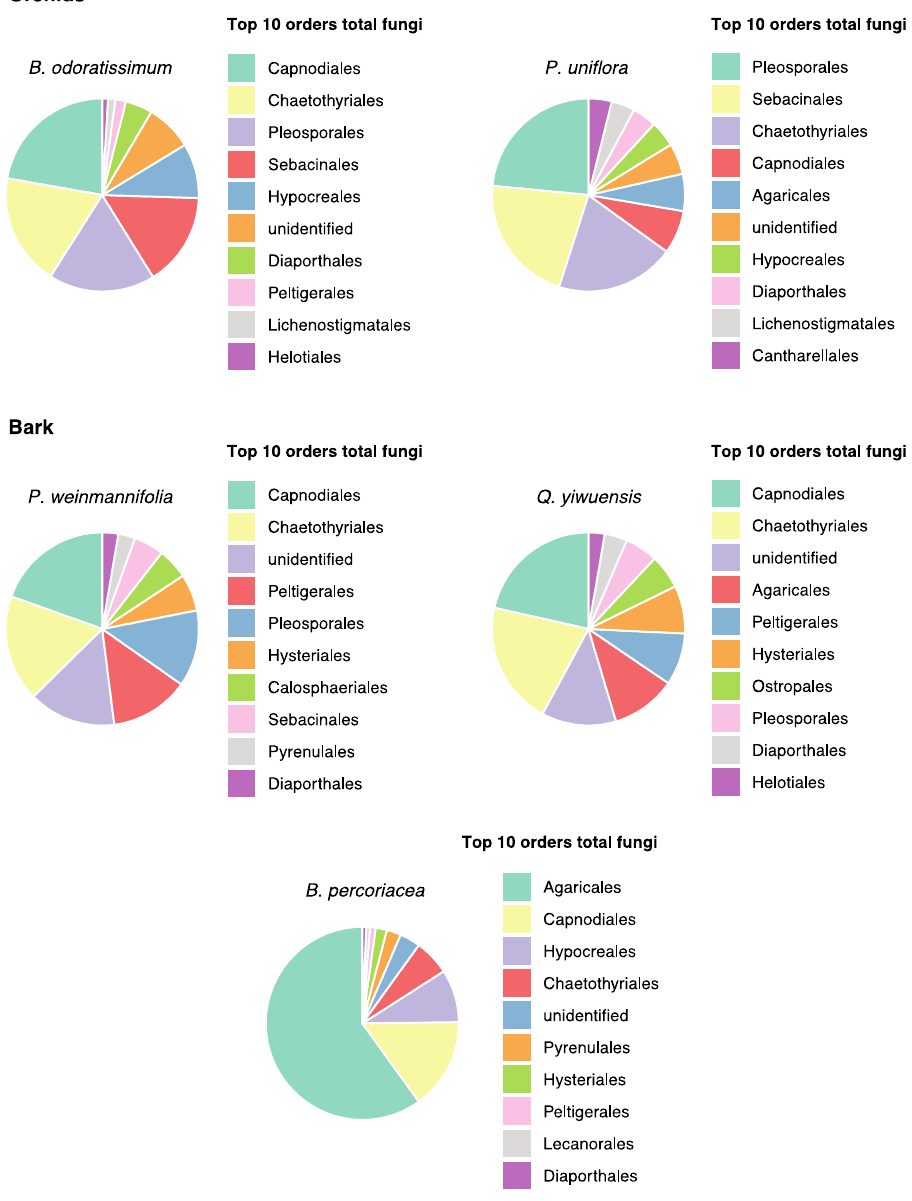
Figure 2. Most abundant orders (top 10) of total fungi present in orchids and bark